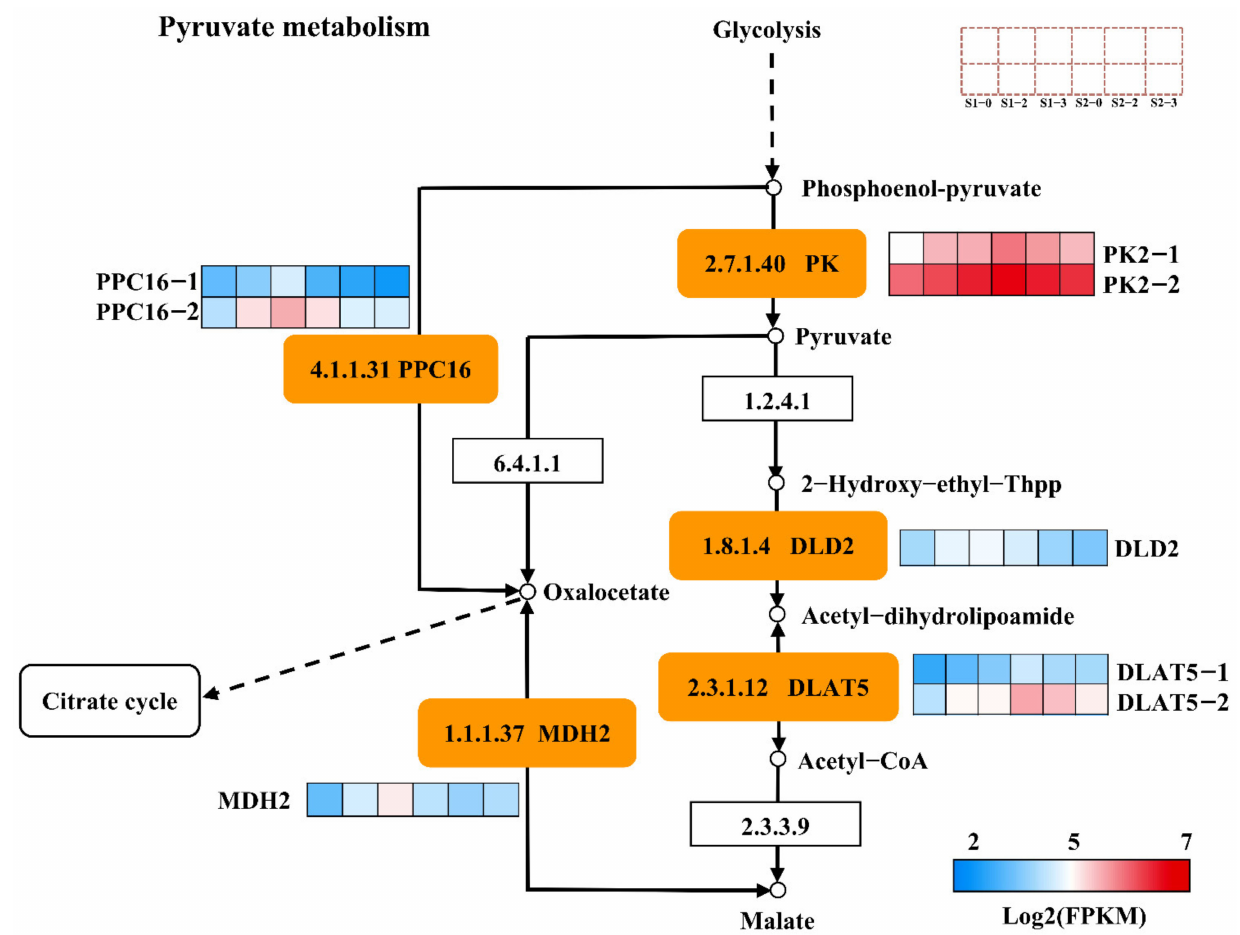
Figure 7. Regulation of pyruvate metabolism pathways in different nitrogen levels. The expression of DEGs is represented by Log2(FPKM). The color from blue to red represents the expression value from low to